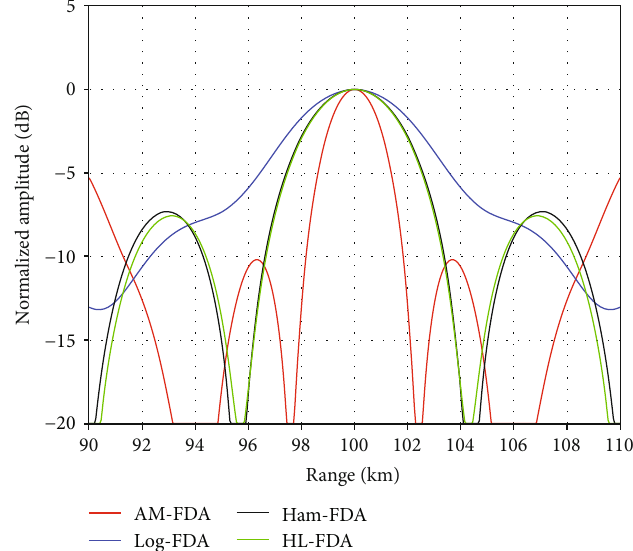
Figure 6: The equivalent transmit beampatterns in the pro fi le of